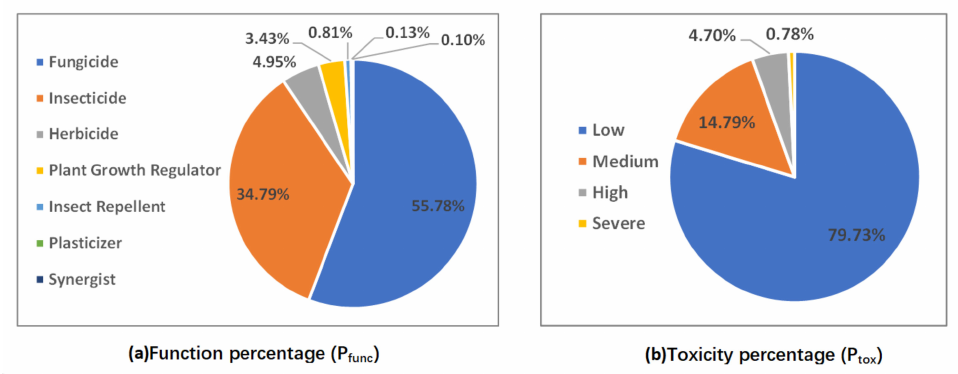
Figure 7. Function percentage ( P func ) and toxicity level percentage ( P tox ) in detected